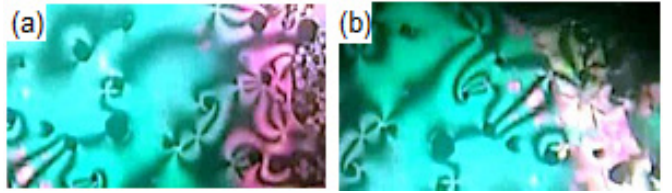
Figure 2. Images (320 × 97 px) of N phases under POM observed on heating for compounds ( a ) I8 d at 190.0 °C and ( b ) I16 b at 120.0 °C. Table 1. Mesomorphic temperature of transitions ( T °C), enthalpy of transition Δ H , kJ/mole, and normalized entropy of transition Δ S /R for investigated set, In x .